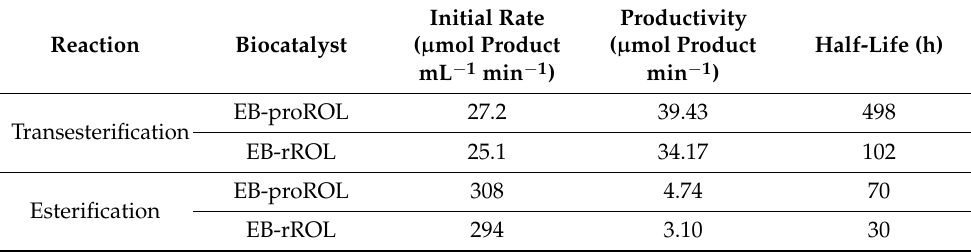
Table 4. EB-rROL and EB-proROL initial transesterification and esterification rates, productivity and half-lives as calculated by using the best-fitting deactivation